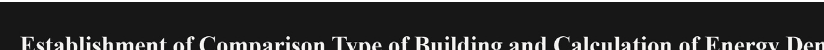
Figure 1. Graphical user interface of Part 1.